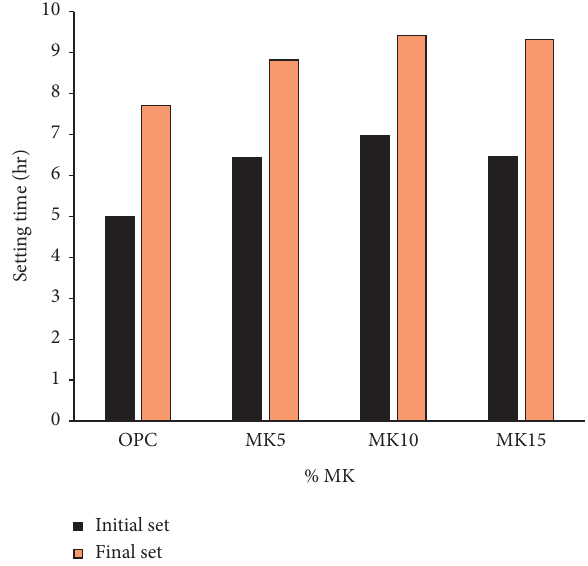
Figure 5: Setting time results for concrete specimens containing metakaolin [18].